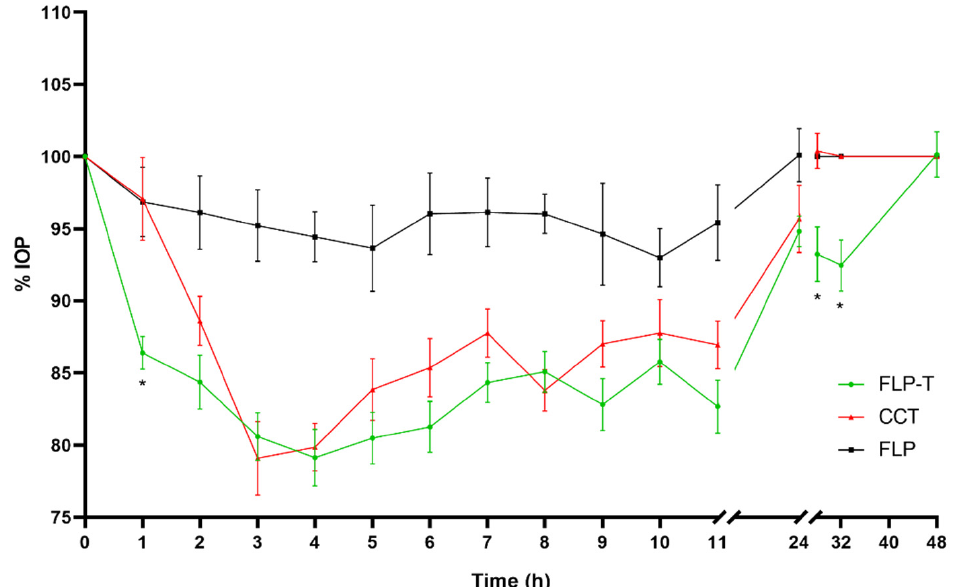
Figure 10. Decrease in intraocular pressure after administration of the liposomal formulation containing travoprost and HPMC (0–48 h), with statistical significance between CCT and FLP-T formulations (* p < 0.05).